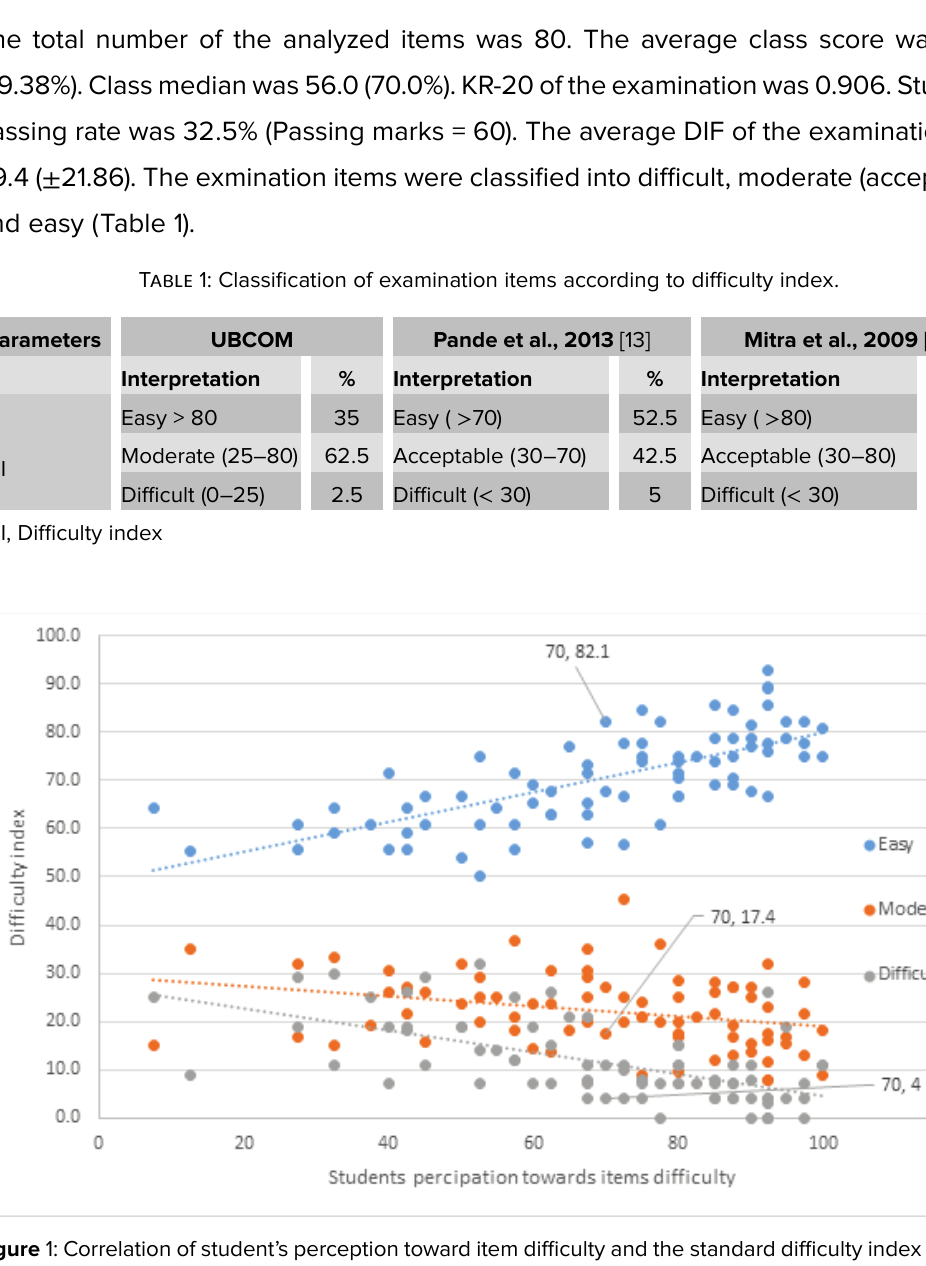
Figure 1: Correlation of student’s perception toward item difficulty and the standard difficulty index of